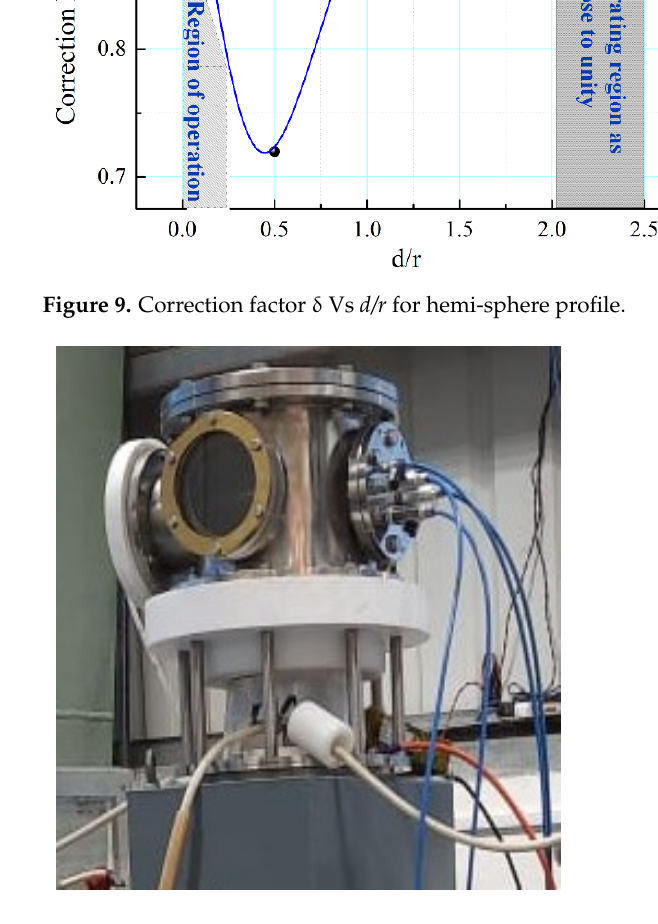
Figure 10. Sparkgap characterization test bench setup.